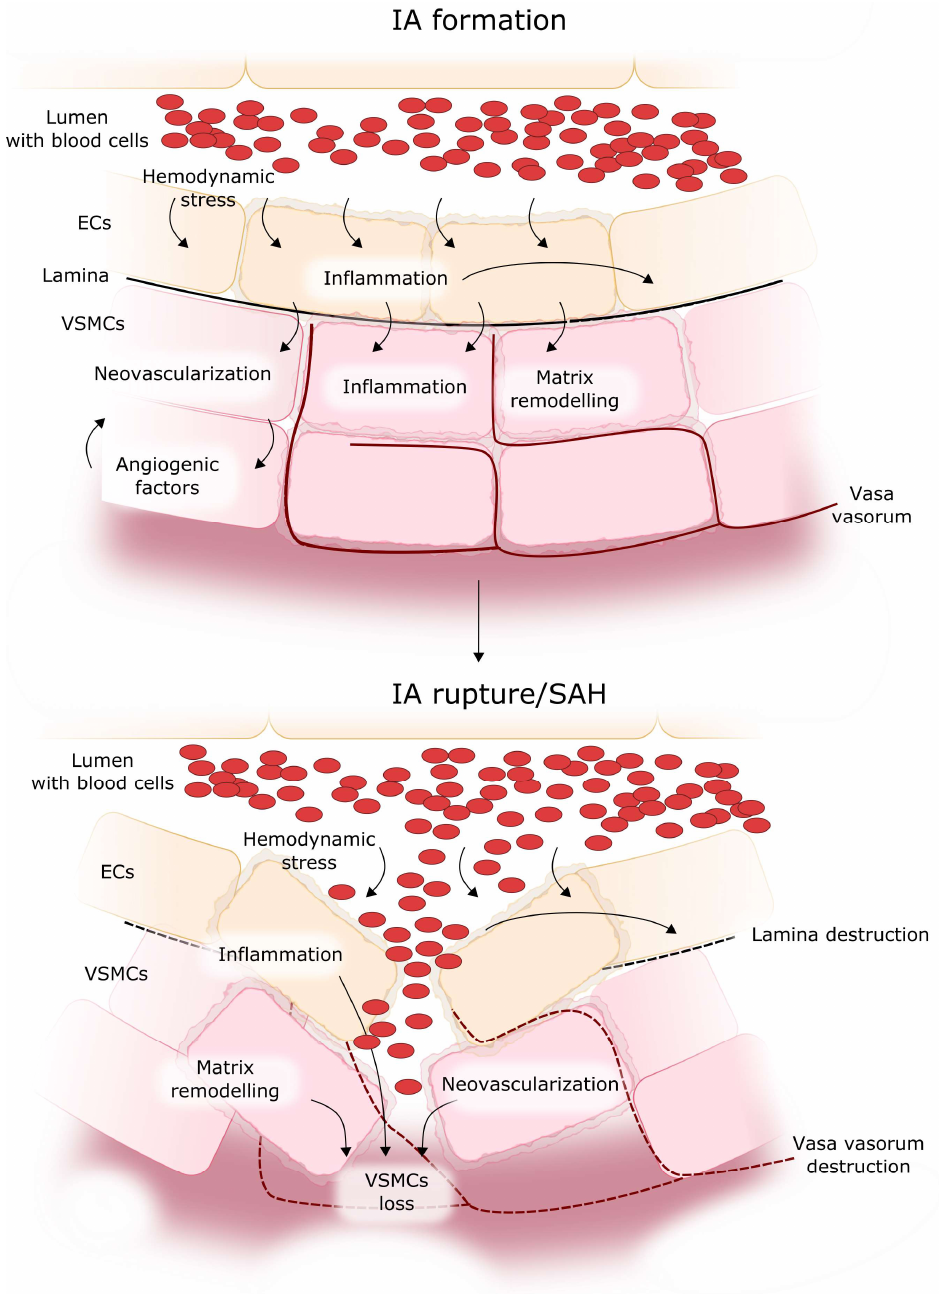
Figure 2. Mechanism of IA formation, progression, and rupture. Hemodynamic stress in a blood vessel stimulates inflammation in the endothelial cells (ECs), which promotes lamina degradation and evokes changes in vascular smooth muscle cells (VSMCs), including inflammation, neovascularization and matrix remodeling, which together modify the properties of the blood vessel wall. Permanent inflammation leads to the degeneration of VSMCs, resulting in thinning of the VSMC layers, increase in their fragility, and finally in IA rupture. Red dashed lines denote vasa vasorum, black dashed lines: destroyed lamina, red ovals represent blood cells.